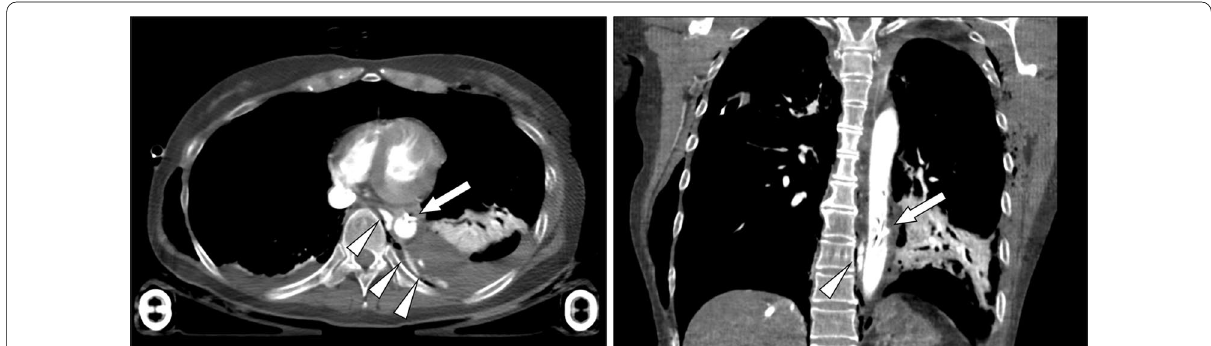
Fig. 1 Computed tomography findings after aortic cross-clamping. Contrast-enhanced computed tomography showing an endovascular balloon in the thoracic aorta (arrow) and extravasation of contrast medium adjacent to the descending aorta